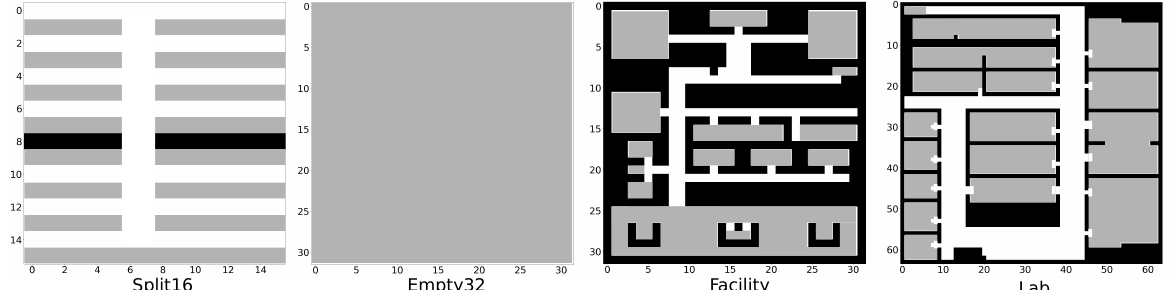
Figure 3. The four environments used in the experimental setup. From left to right : the split16 environment of size 16 × 16, the empty32 environment of size 32 × 32, the facility environment of size 32 × 32, and last the lab environment of size 64 × 64. Black represent walls, white and grey areas are free cells where robots can move, but tasks can appear only in the gray shadowed areas.